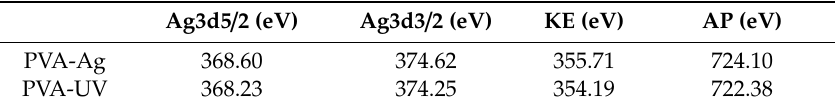
Table 1. XPS characteristic peak and auger parameter.